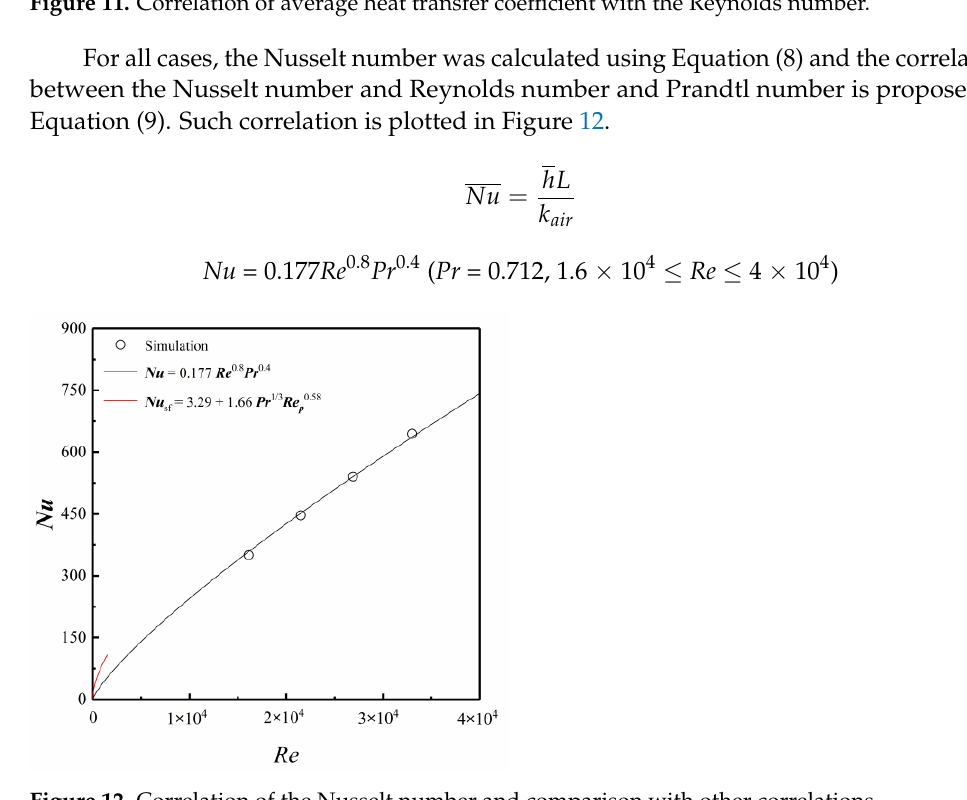
For all cases, the Nusselt number was calculated using Equation (8) and the correlation